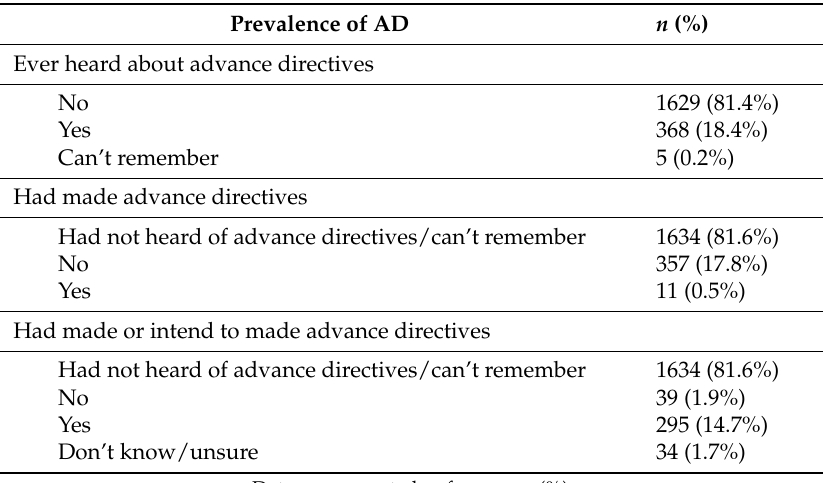
Table 2. Prevalence of advance directives ( n =